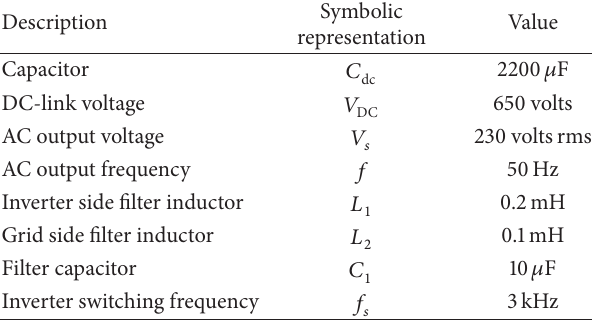
Table 2: Design parameters for